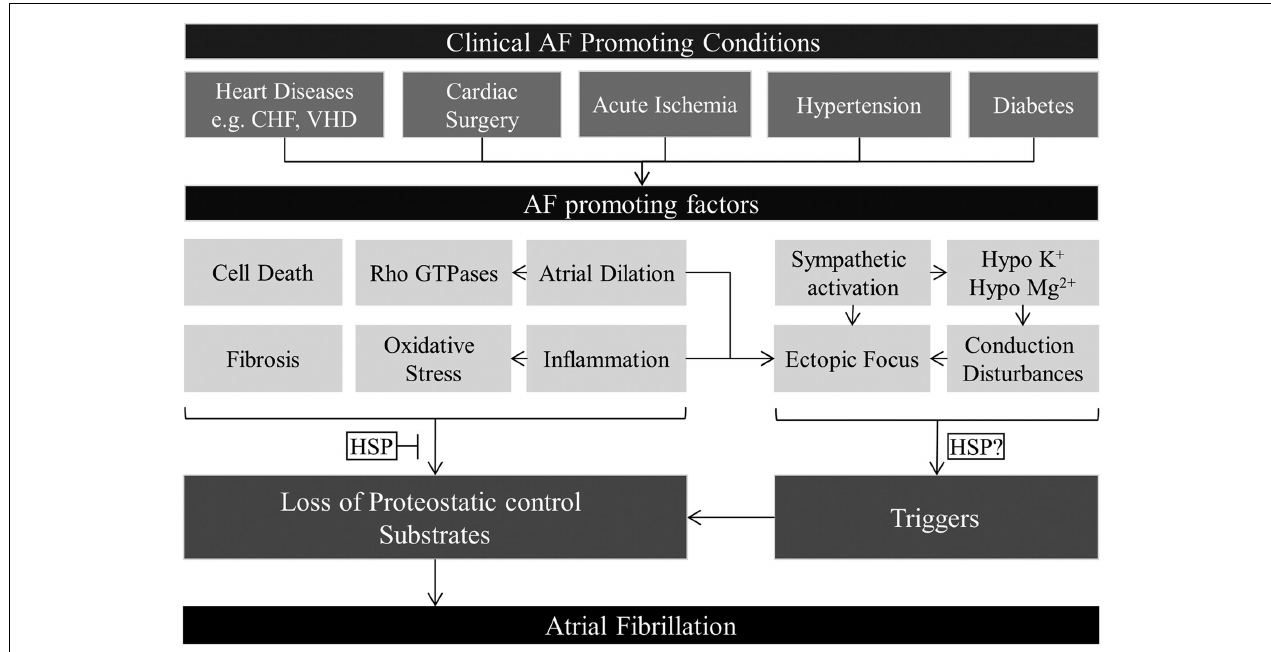
on the vulnerable substrate to induce first-onset AF. Prevention and/or normalization of the cardiomyocyte proteostasis by inducing HSP expression could prevent AF substrate formation and prove an effective approach in preventing first-onset AF in response to various AF-promoting